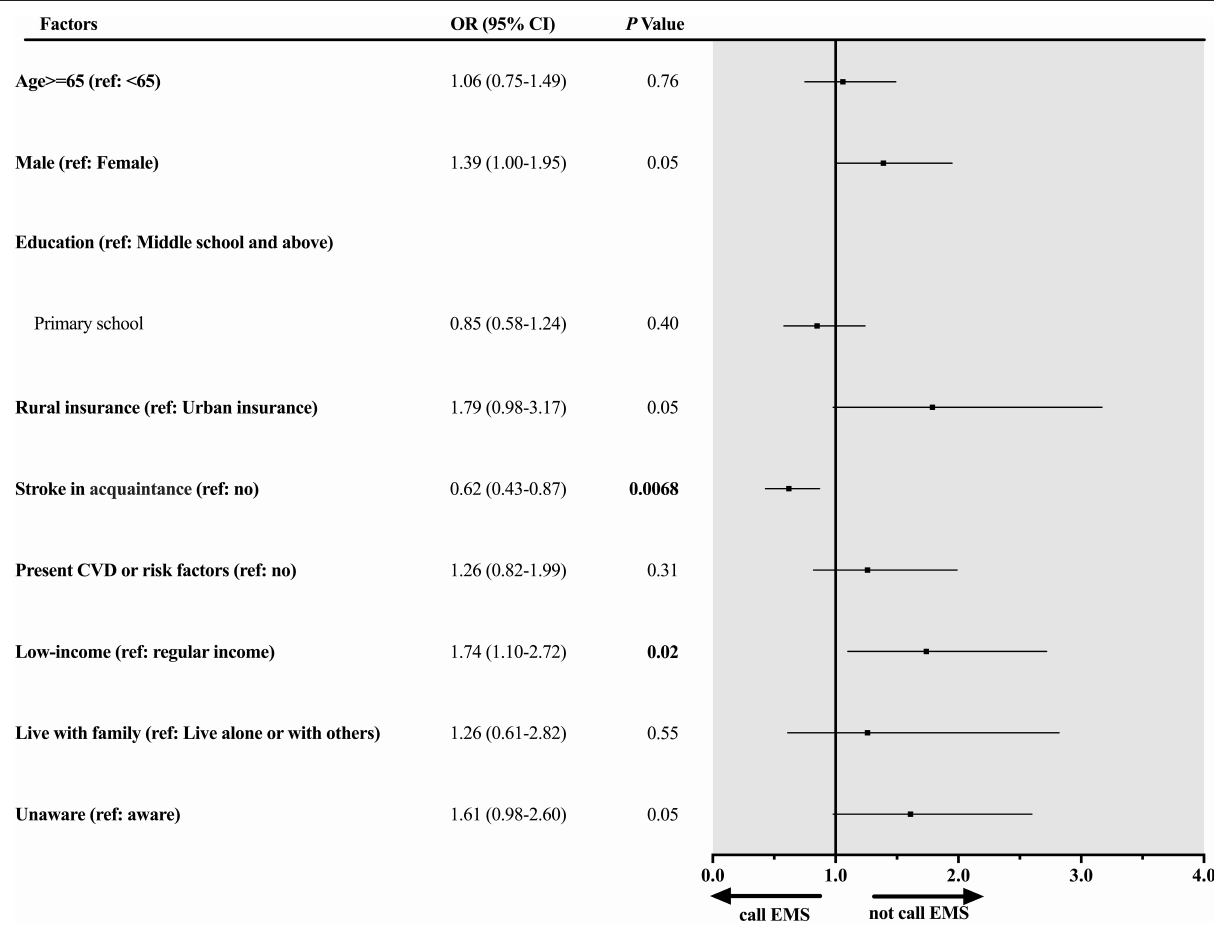
FIGURE 2 | Factors associated with not calling EMS among urban participants with previous TIA. Forest plot and corresponding statistical results (OR, 95% CI, and p- value) illustrate risk factors associated with not calling EMS among urban participants with previous